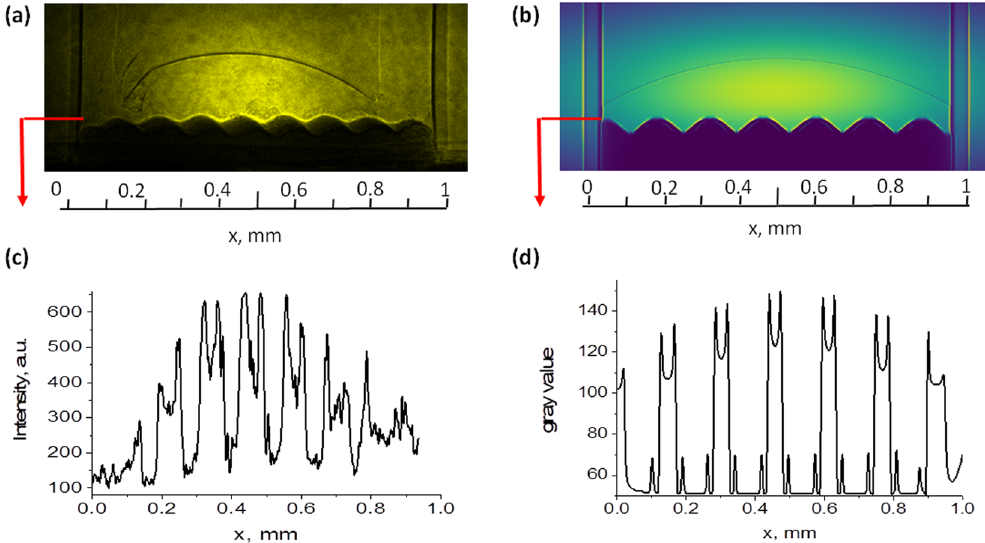
Figure 6. Comparison of experimental image obtained on the LiF crystal with modelling with lineout taken across rippled target edge. Phase contrast enhancement is observed in both cases.